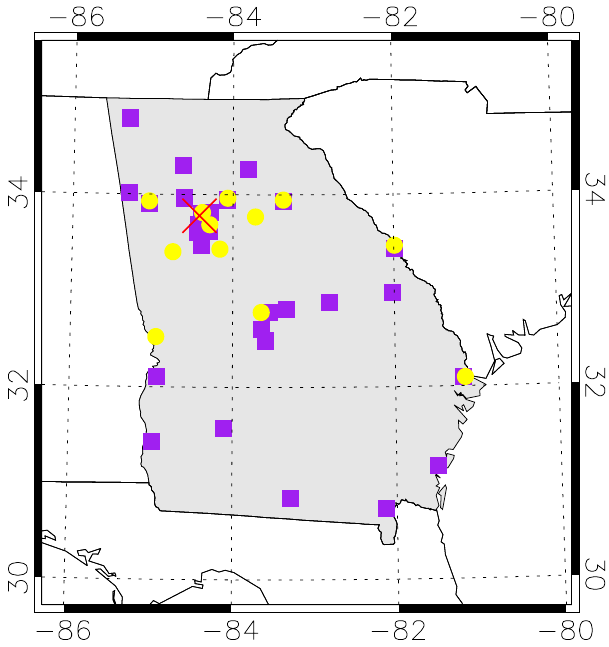
Fig. 1. Map of the US Southeast. Green box with red outline de- notes study spatial domain for satellites 5 ◦ × 5 ◦ . Yellow markers represent EPA PM 2 . 5 monitors (PM 2 . 5 , FRM ). Purple markers rep- resent TEOM PM 2 . 5 monitors (PM 2 . 5 , TEOM